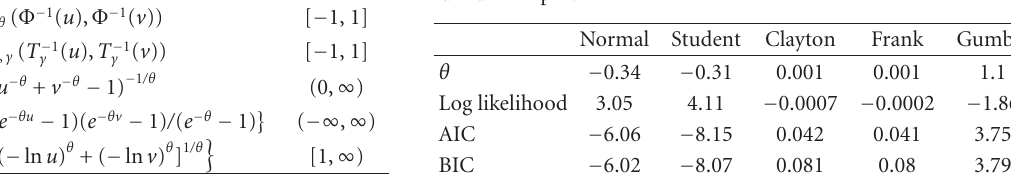
Figure 12: Real versus Frank fitted CDF. Note: The dashed lines are the real CDFs while the solid lines are the simulated CDFs. Table 5: Results of di ff erent copula models for temperature and rainfall in